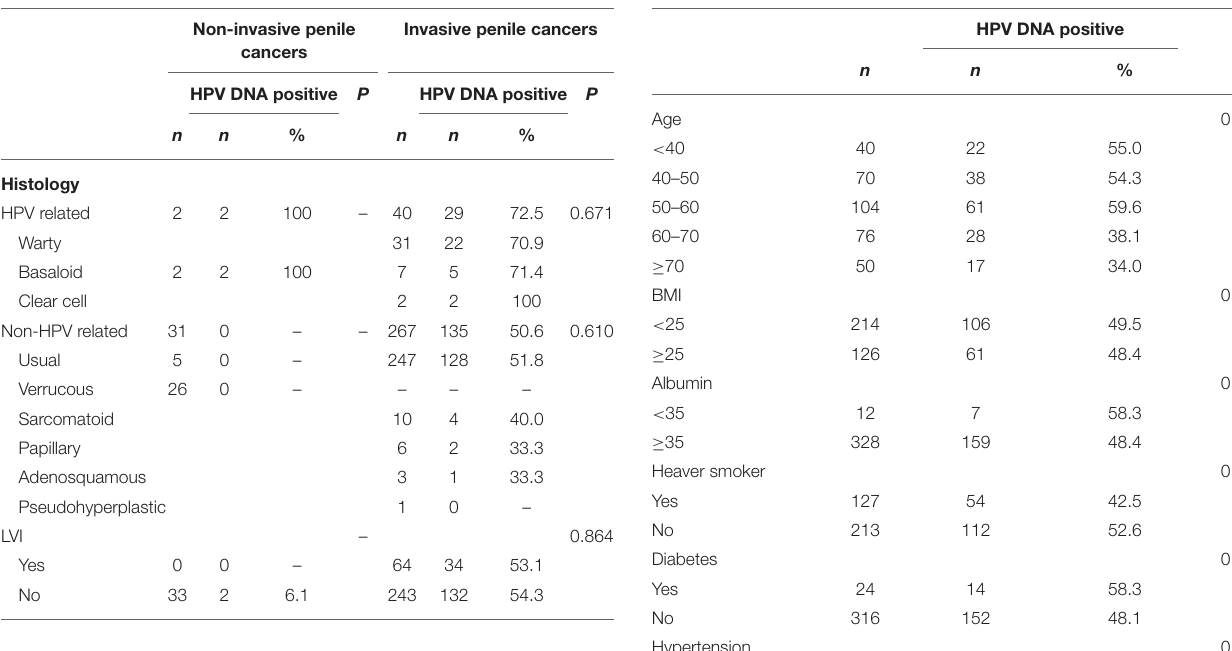
TABLE 5 | Demographics, Smoking, nutrition, comorbidity, and human papillomavirus DNA prevalence in penile